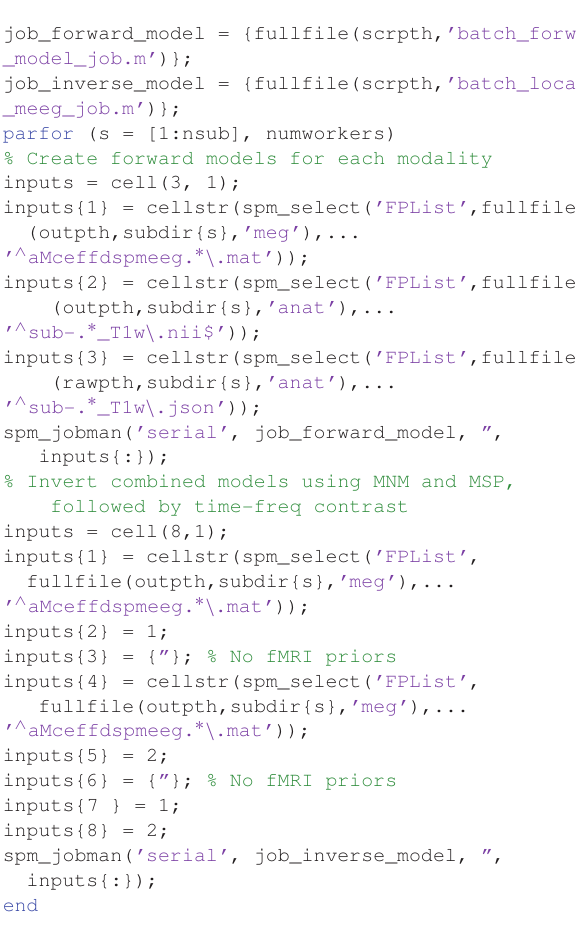
with the red line being the currently selected condition, here “1” for Famous faces (press the “condition” button to toggle through the other conditions). If you press “ display ” under the “ Window ” button, you can see a MIP for the time-frequency contrast limited to the 100–250 ms, 10–20 Hz specified above, or if you press the “ display ” under the “ Image ” button, you will see a rendered